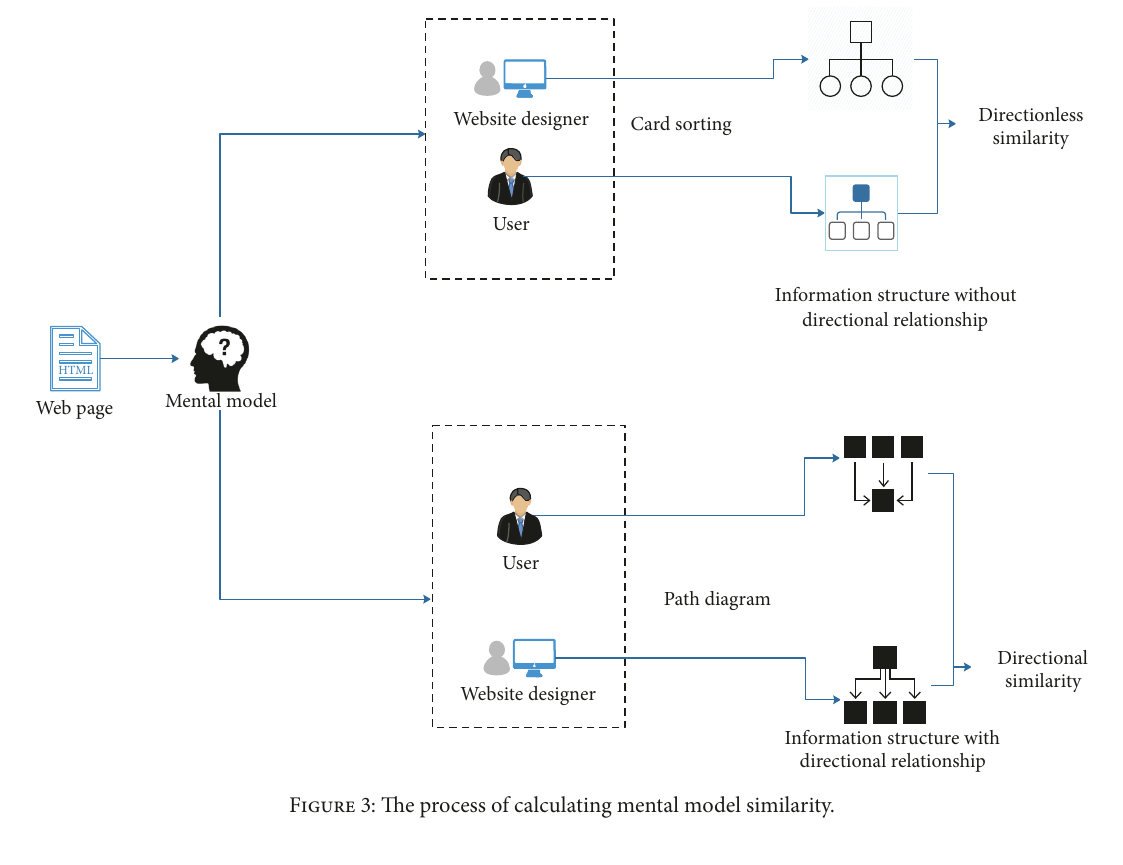
Figure 3: The process of calculating mental model similarity.